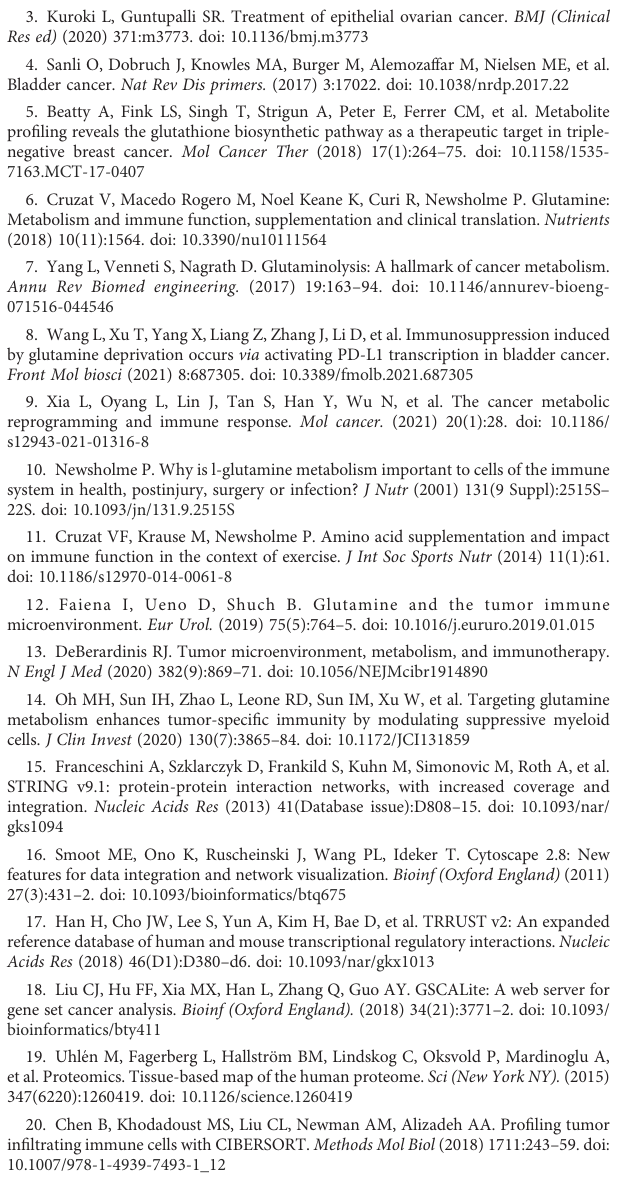
SUPPLEMENTARY FIGURE 4 Comparison of GMII index with other prognostic models of bladder cancer SUPPLEMENTARY FIGURE 5 Prognosis curve among clinical subgroups SUPPLEMENTARY FIGURE 6 Analysis of tumor mutation load. (A) TMB differences between high-GMII and low-GMII groups. (B) Survival curves of high-TMB and low-TMB groups. (C) Survival curve after combination of TMB and GMII.